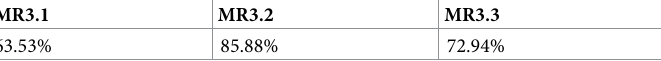
Table 8. Mutation scores of MRs for the deposit cancellation event for all mutants.